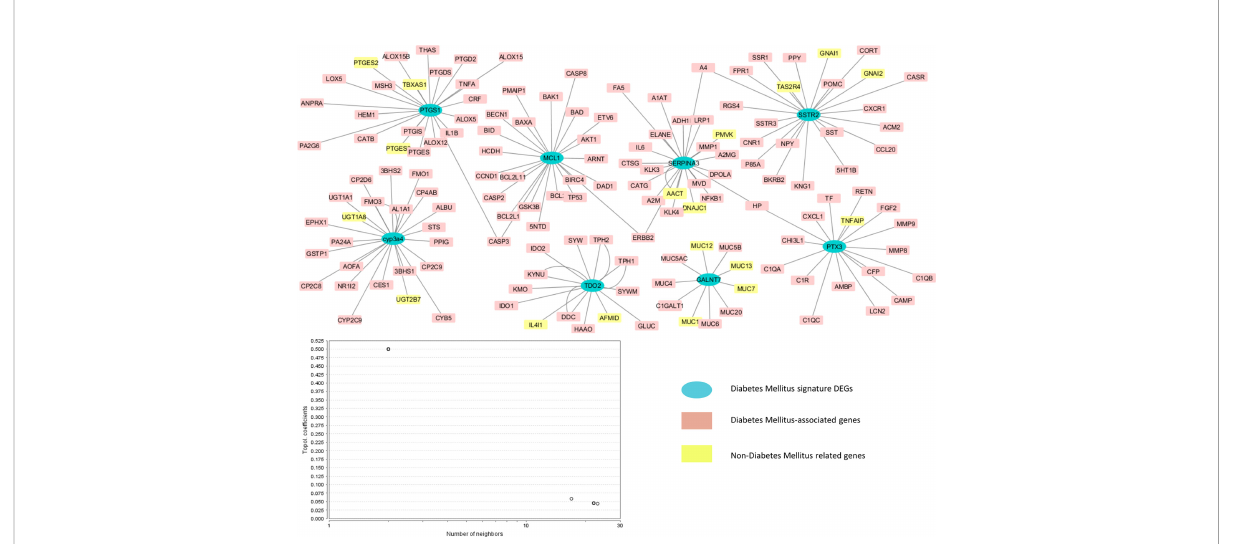
FIGURE 5 Genetic network of type 2 diabetes-associated differentially expressed signature genes. The blue nodes indicate the type 2 diabetes mellitus- associated potential biomarkers, the yellow nodes represent the non-type 2 diabetes mellitus target proteins, and the pink nodes represent type 2 diabetes mellitus-related DEGs.